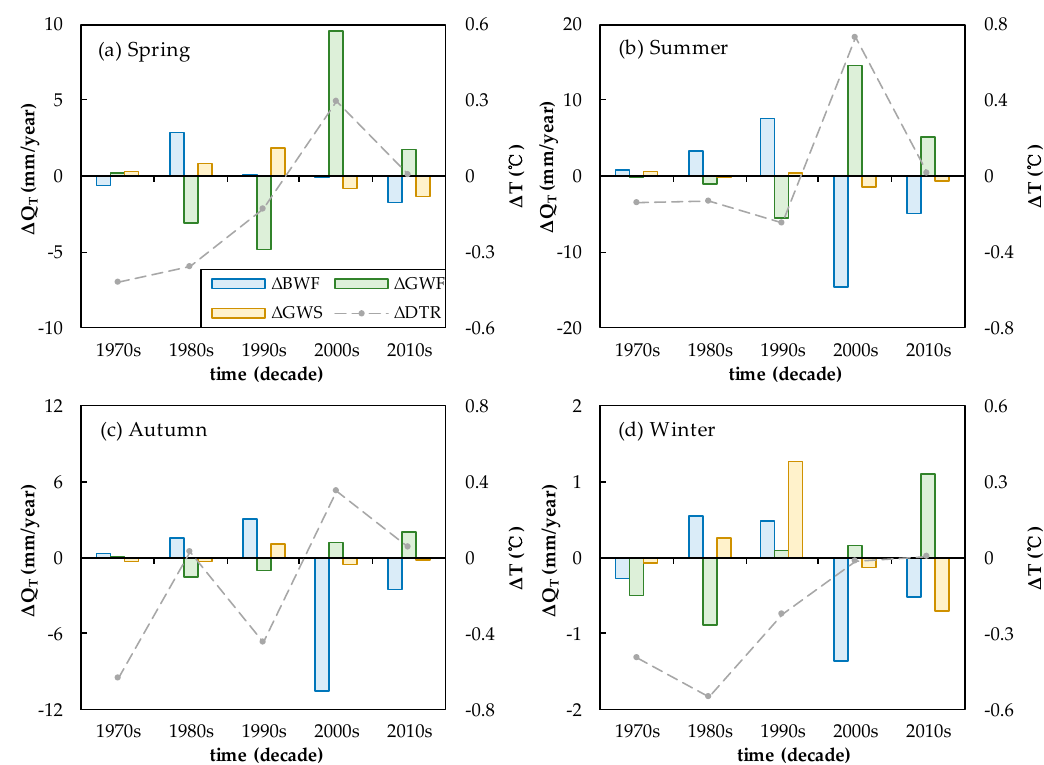
Figure 6. Changes in seasonal hydrological components impacted by temperature.